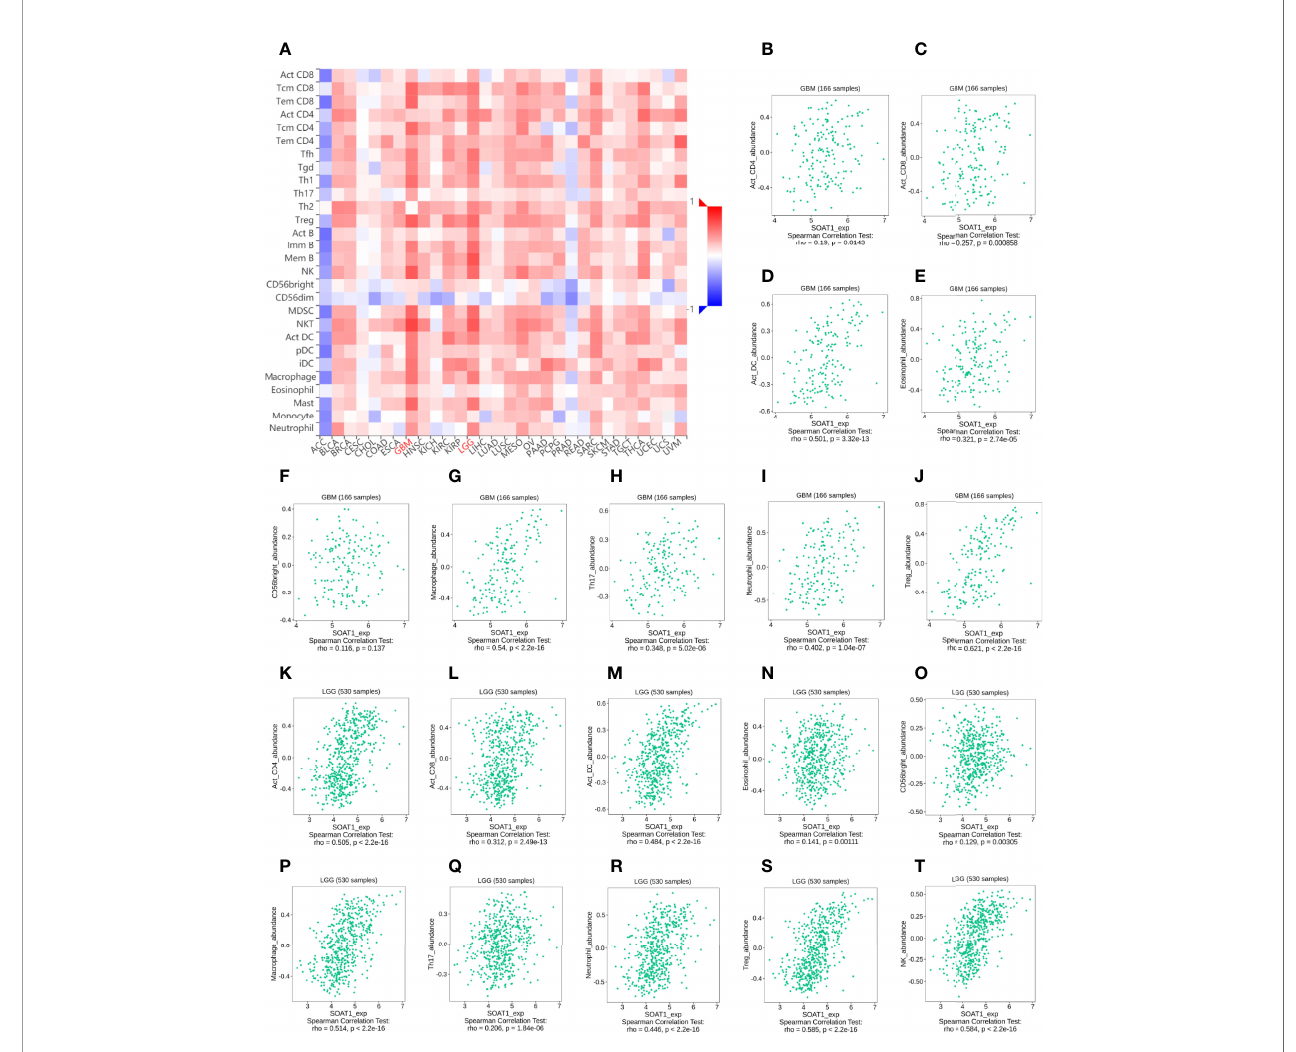
FIGURE 4 | SOAT1 expression was associated with immune in fi ltration in the tumor microenvironment. (A) Pan-cancer analysis of the correlation between SOAT1 expression and immune in fi ltrating cells based on TISIDB dataset. (B – T) Correlation between SOAT1 expression and immune in fi ltrating cells in GBM and LGG based on TISIDB dataset. aDC, activated DC; DC, dendritic cells; iDC, immature DC; NK, natural killer; pDC, plasmacytoid DC; Th cells, T helper cells; Tcm, T central memory; Tem, T effector memory; TFH, T follicular helper; Tgd, T gamma delta; Th cells, T helper cells; Treg, T regulatory cells; Imm B, immature cell B; Mem B, memory cell B; MDSC, myeloid-derived suppressor cells; SOAT1 , sterol O-acyltransferase 1 ; LGG, lower grade glioma; TISIDB, an integrated repository portal for tumor-immune system